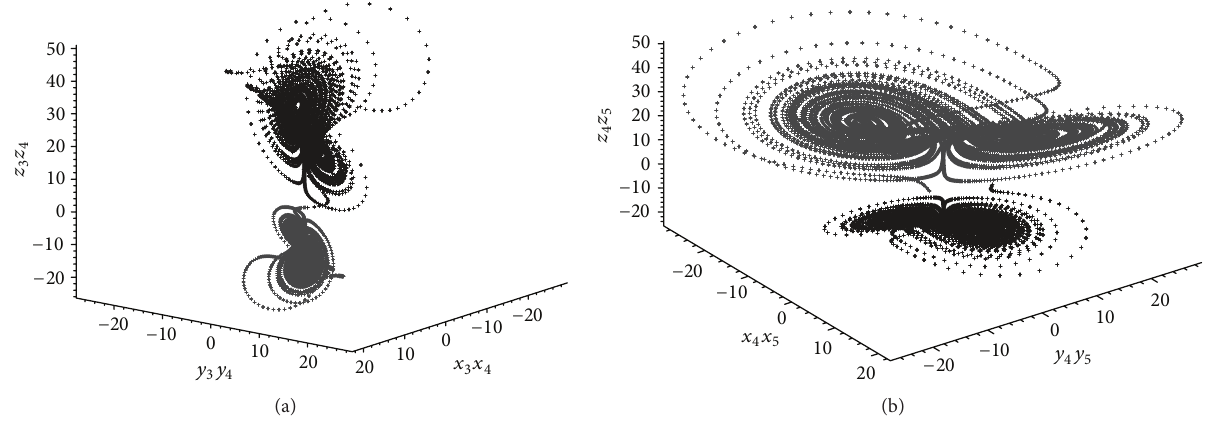
Figure 9: The chaos attractors between node 3 and node 4 (a) and between node 4 and node 5 (b).